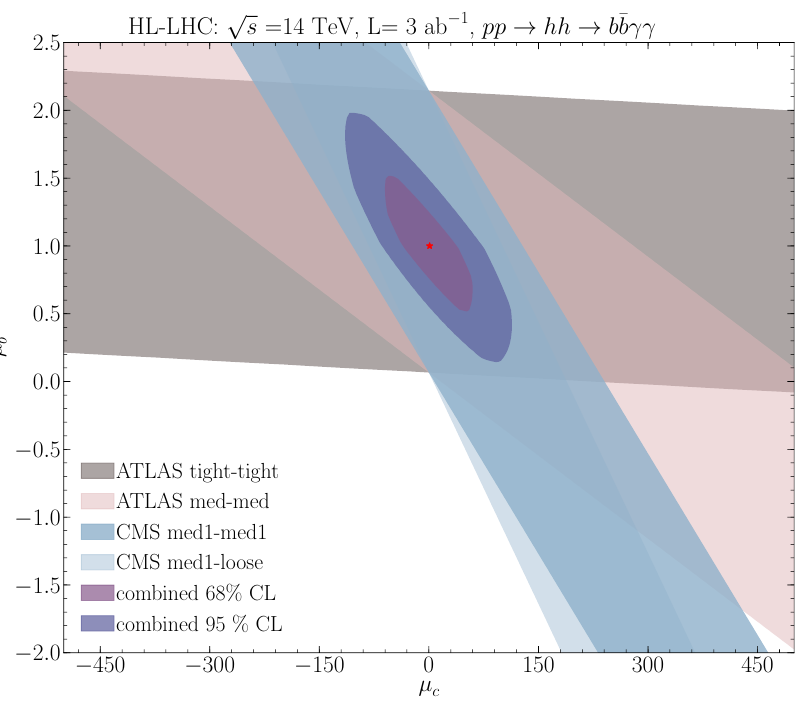
Figure 15 . The 95 % CL contours of (cid:22) b vs (cid:22) c , obtained from (cid:12)tting of the signal strength for several CMS and ATLAS b -tagging working points. Their combination with the 68% and 95% CL upper limits on (cid:22) b and (cid:22) c are